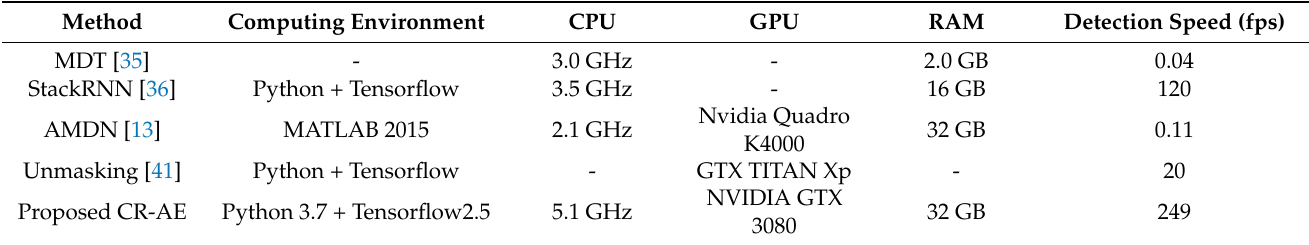
Table 4. Running time comparison of the UCSD Ped2